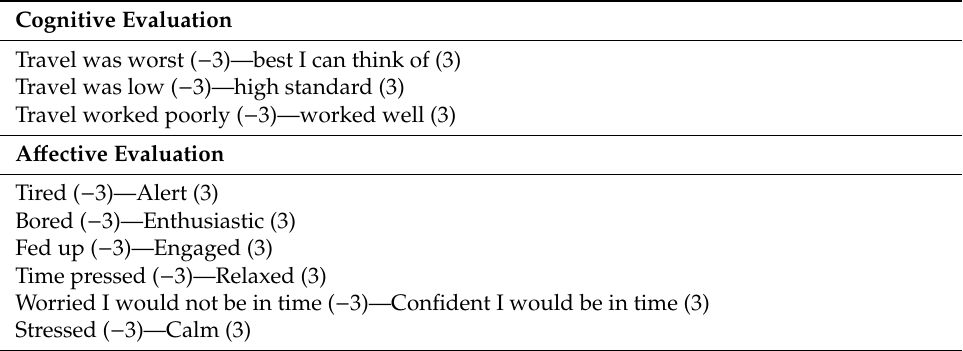
Table 2. Satisfaction with Travel Scale